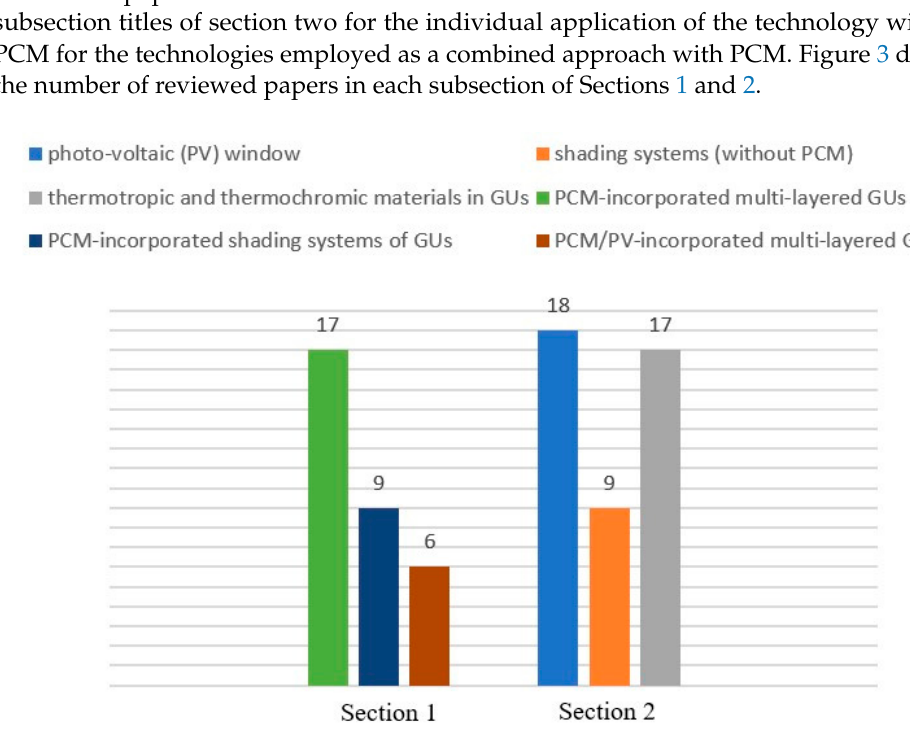
Figure 3. The number of reviewed papers in each subsection of Sections 1 and 2.